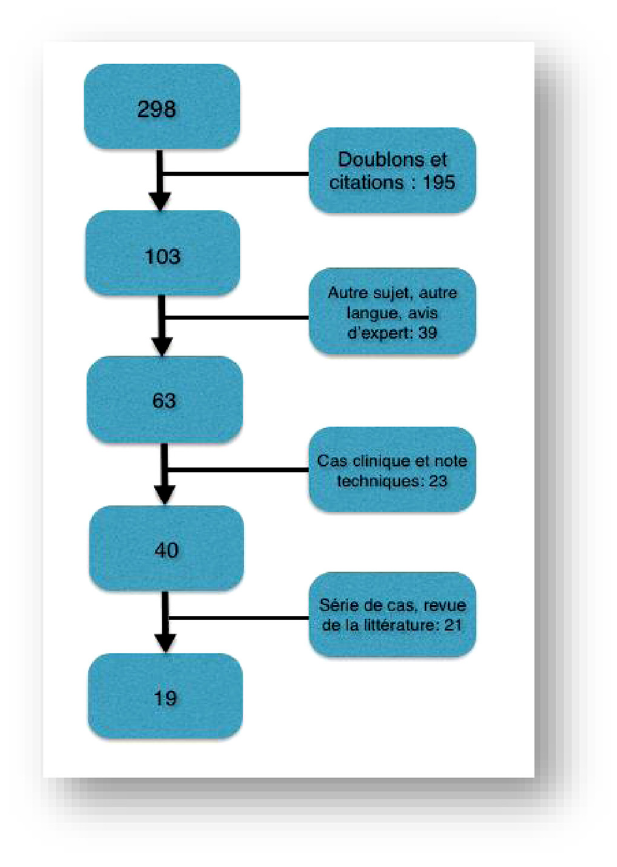
Fig. 6. Flow chart of the bilbiographic review.